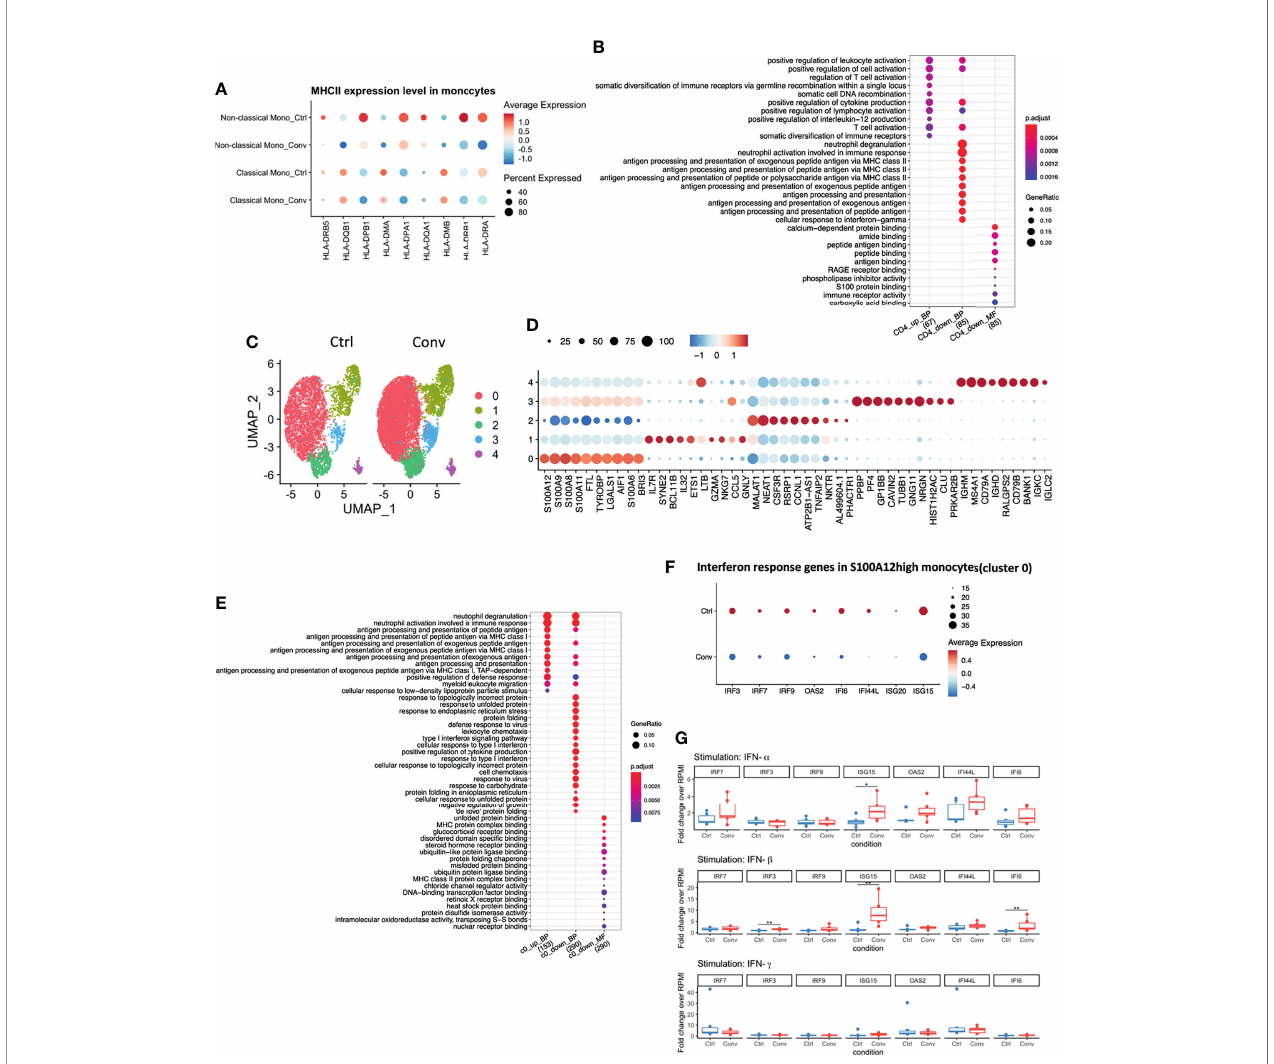
FIGURE 3 | Antigen processing and presentation via MHC II were downregulated in convalescent COVID-19 individuals, while baseline expressions of Interferon- Stimulated Genes (ISGs) in PBMCs are comparable to uninfected individuals. (A) Dot plot showing the MHC II expression levels across different conditions. The size of the dot depicts the percentage of cells within classical monocytes or non-classical monocytes; the color encodes the average expression level (low=blue, high=red). (B) Dot plot showing the GO enrichment analysis of DEGs in CD4+ T cells. The color and size of the dot indicate the signi fi cance (adjusted P-value ) and the percentage of DEGs in the given GO term, respectively (BP, biological process, MF, molecular function). Top 10 enriched categories were shown. (C) UMAP of single-cell RNA sequencing data in classical monocytes in convalescent COVID-19 (n = 11) and control (n=9) samples. 5 cell clusters were identi fi ed. (D) Dot plot showing the top 10 markers for each cell cluster using the Wilcoxon Rank Sum test. The 0-4 in the y-axis means the cell clusters from(C). The color and size of the dot indicate the gene expression level (low=blue, high=red) and percentage of cells which expressing these markers. (E) Dot plot showing the GO enrichment categories of the DEGs found in each cluster. (F) Dot plot showing the interferon response genes expression levels across different conditions. The size of the dot depicts the percentage of cells expressing the indicated genes within cluster0; the color encodes the average expression level (low=blue, high=red). (G) Box plots showing the gene expressions of the seven interferon-stimulated genes ( IRF7, IRF9, IRF3, ISG15, OAS2, IFI44L , and IFI6 ) 24 hours after stimulation with recombinant human IFN- a , IFN- b , and IFN- g . Fold changes over RPMI (unstimulated condition) were reported. Mann-Whitney test was used to analyze the differences between controls and convalescent patients (n = 6, * P value < 0.05, ** P value <